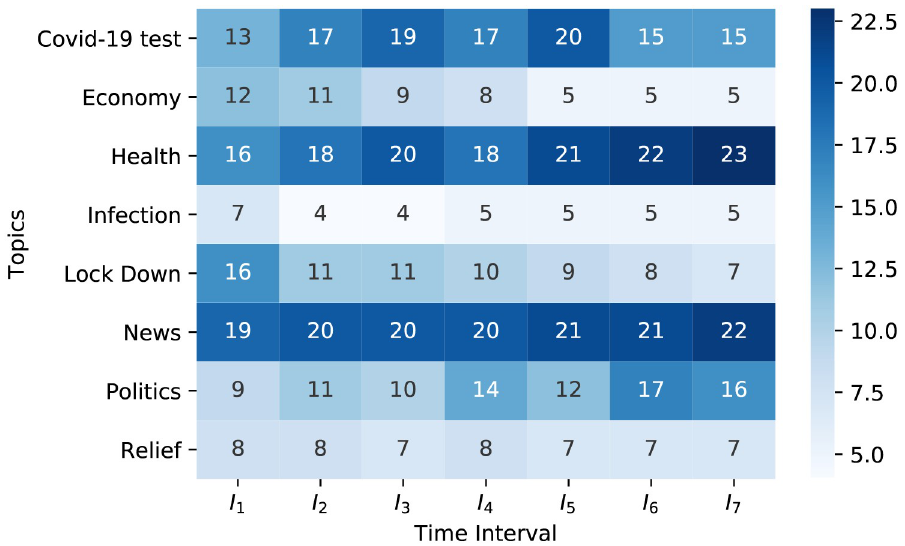
Fig 3. Heatmap representing the percentage of each topic discussed among users at various time interval I (displays the top eight discussed topics at seven different time-intervals).